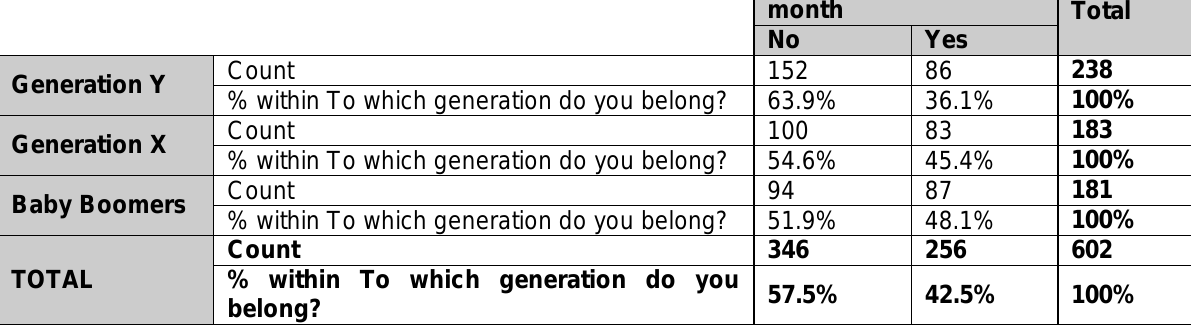
Table 7: Generations supporting NPOs once a month